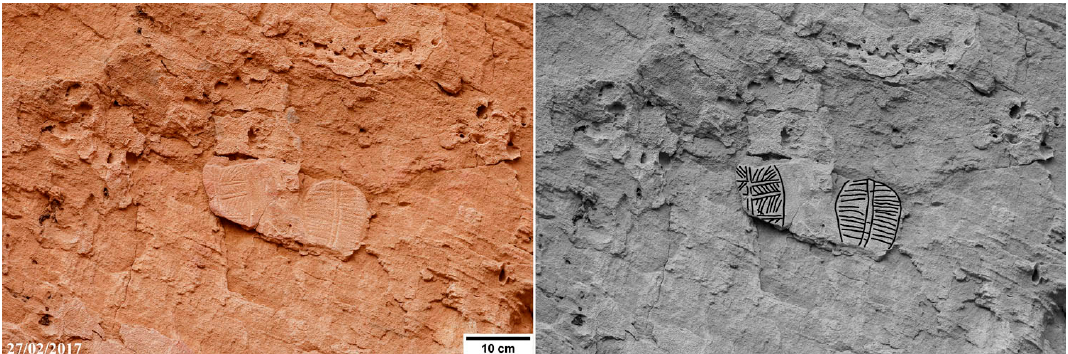
Figure 16. Relics of a cluster of oval engravings (E3) with various internal elements and decorative patterns of lines (black and white version: interpretation by tracing, Photo: Alessandro Menardi Noguera). into two sectors, internally decorated with horizontal lines (Figure 17). A reticular graphic element subdivides into squares the oval engraving to the left. Patterns of oblique lines, up left ‐ to ‐ right and up right ‐ to ‐ left, symmetrically fill the resulting square subdivisions.